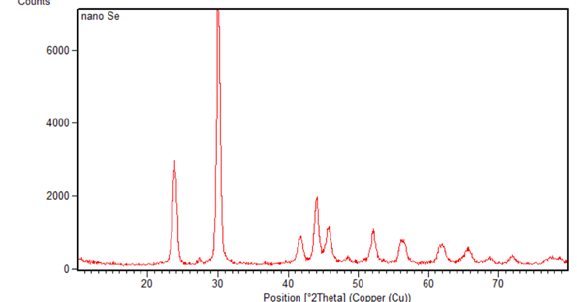
Figure 1. XRD Pattern of Se NPs.